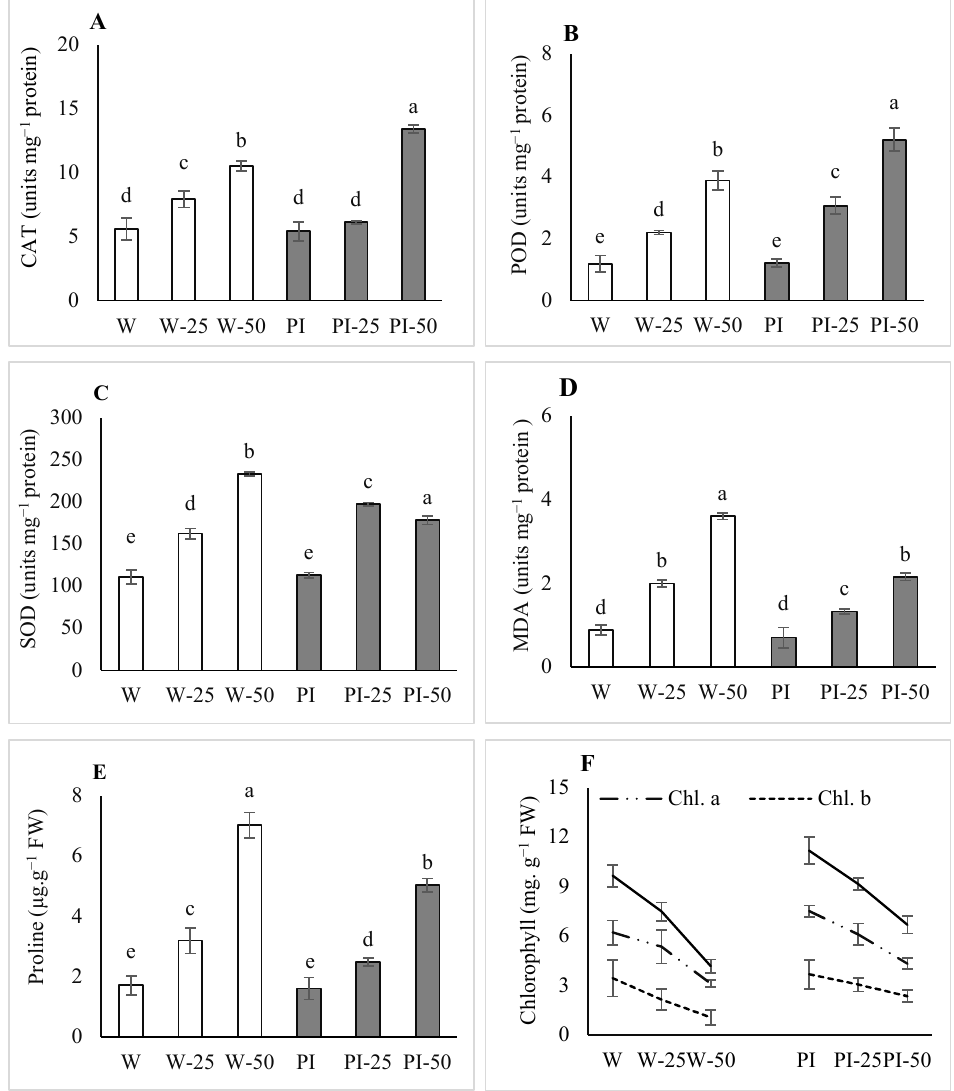
Figure 4. ( A ) Catalase (CAT), ( B ) peroxidase (POD), ( C ) superoxide dismutase (SOD), ( D ) malondialdehyde (MDA), ( E ) proline, ( F ) chlorophyll content in leaves of cucumber plants at 60 days post P. indica inoculation, under well and limited water irrigation regimes. W (normal irrigation), W-25 (moderate water stress; equal 25% less than normal irrigation), W-50 (severe water stress; equal 50% less than normal irrigation), PI (inoculation with P. indica under normal irrigation), PI-25 (inoculation with P. indica under 25% less than normal irrigation), and PI-50 (inoculation with P. indica under 50% less than normal irrigation). Data are means of combined analysis of two grow- ing seasons. Means marked by the same lower-case letter are not significantly different ( p < 0.05). Error bars represent standard error of the means (SE), n = 6.